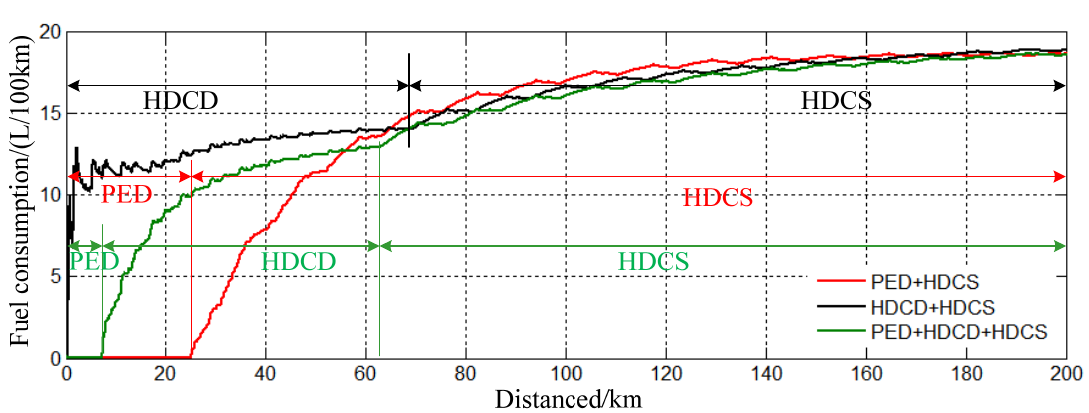
Figure 17. The relationship curves between the fuel economy and trip distance under different strategies.